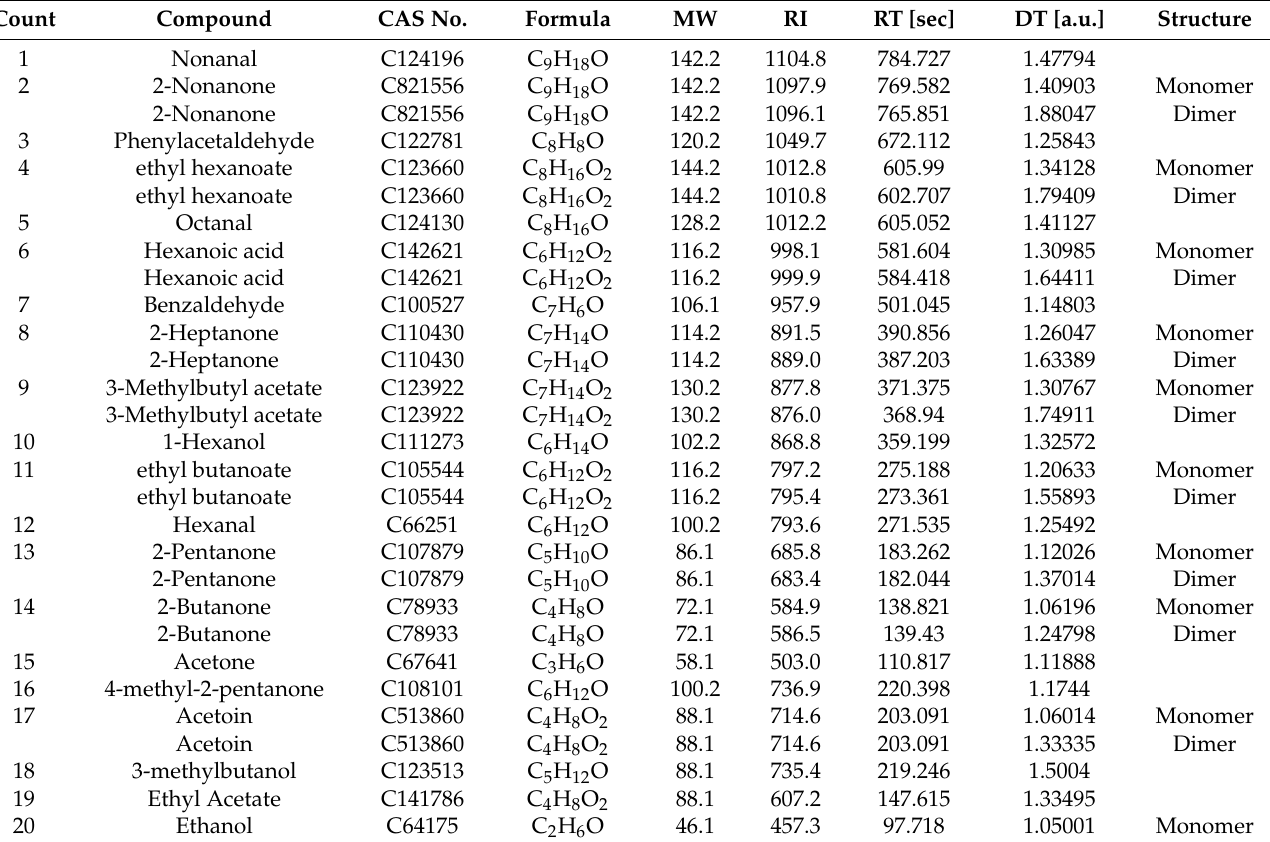
Table 3. Qualitative analysis of volatile organic compounds in raw milk samples, including CAS registry number (CAS No.), molecular weight (MW), retention index (RI), retention times (RT), and relative migration time